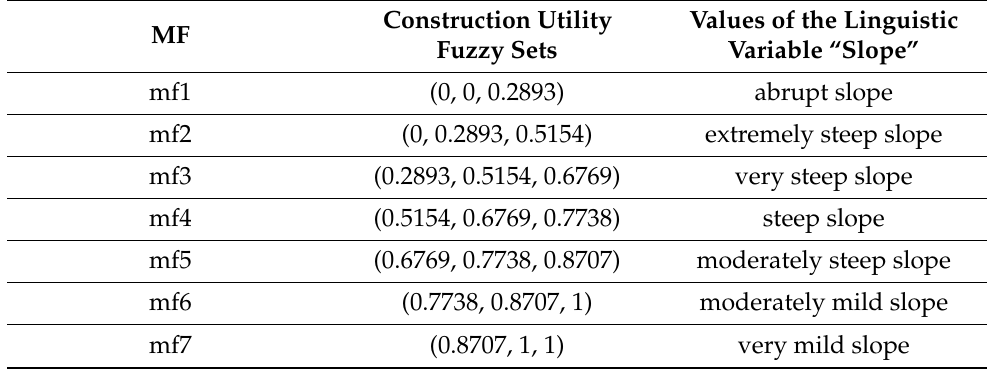
Table 7. Defining fuzzy sets and values of the linguistic variable “Slope”.